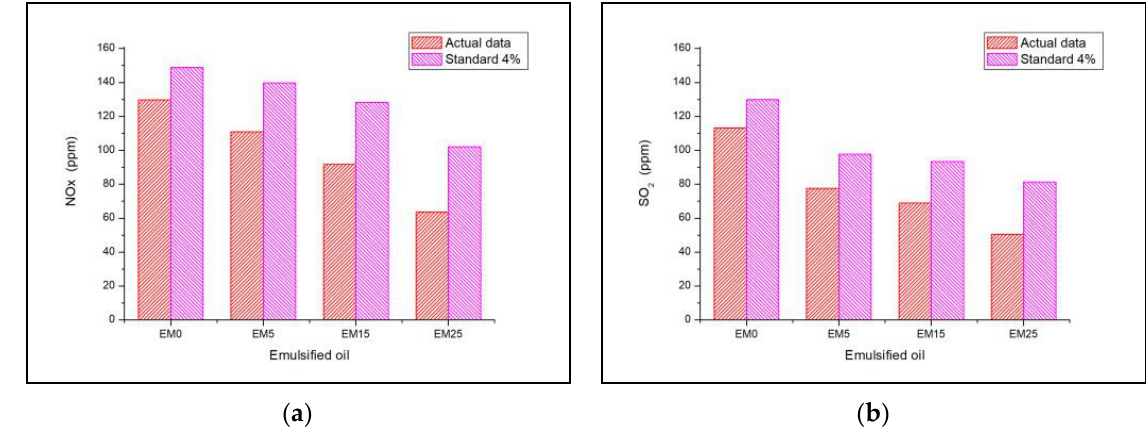
Figure 9. Emission comparison of emulsified oils when standard O 2 4% was applied: ( a ) NO x and ( b ) SO 2 .